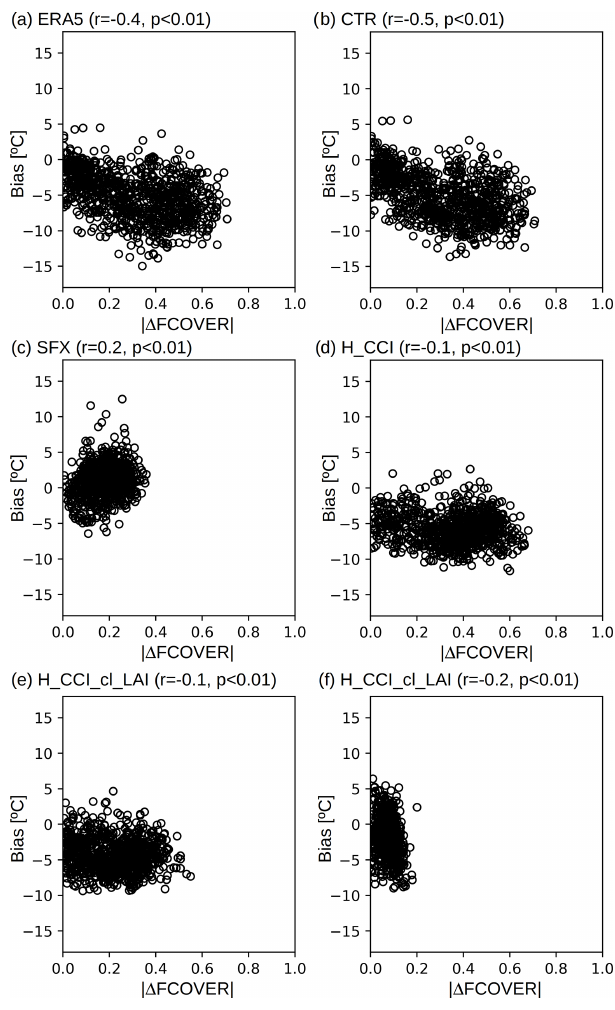
Figure 3. Scatterplots of grid point JJA LST max bias over Iberia un- der clear-sky conditions against absolute error in monthly maximum FCOVER. (a) ERA5; (b) CTR; (c) SFX; (d) H_CCI; (e) H_CCI_cl; and (f) H_CCI_cl_LAI. LSA-SAF LST was considered as reference for computing the LST max errors, while CGLS FCOVER was con- sidered as reference for computing the FCOVER errors. The Pear- son correlation coefficient ( r ) and respective p value are shown for each